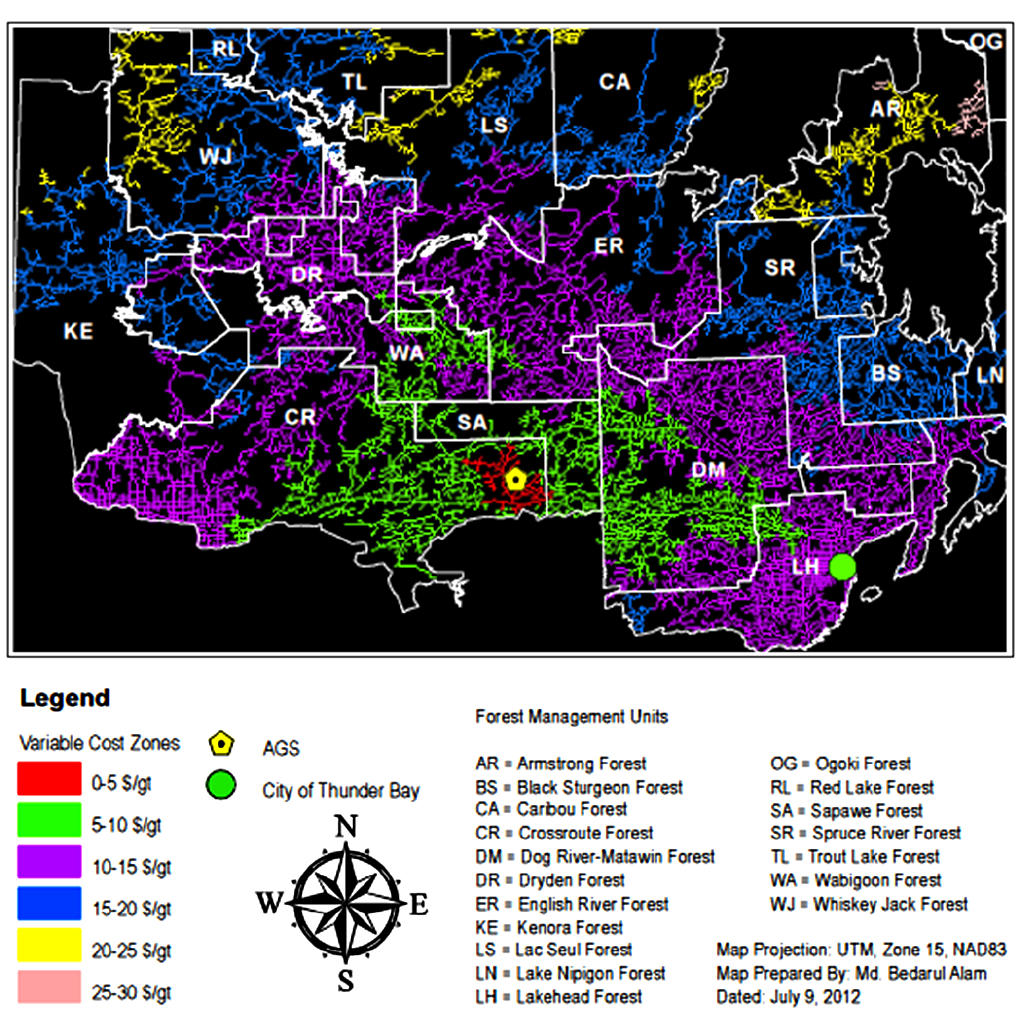
Figure 1. Locations of the City of Thunder Bay and Atikokan Generating Station (AGS) with respect to forest management units and road network (classified in variable transport cost zones) in northwestern